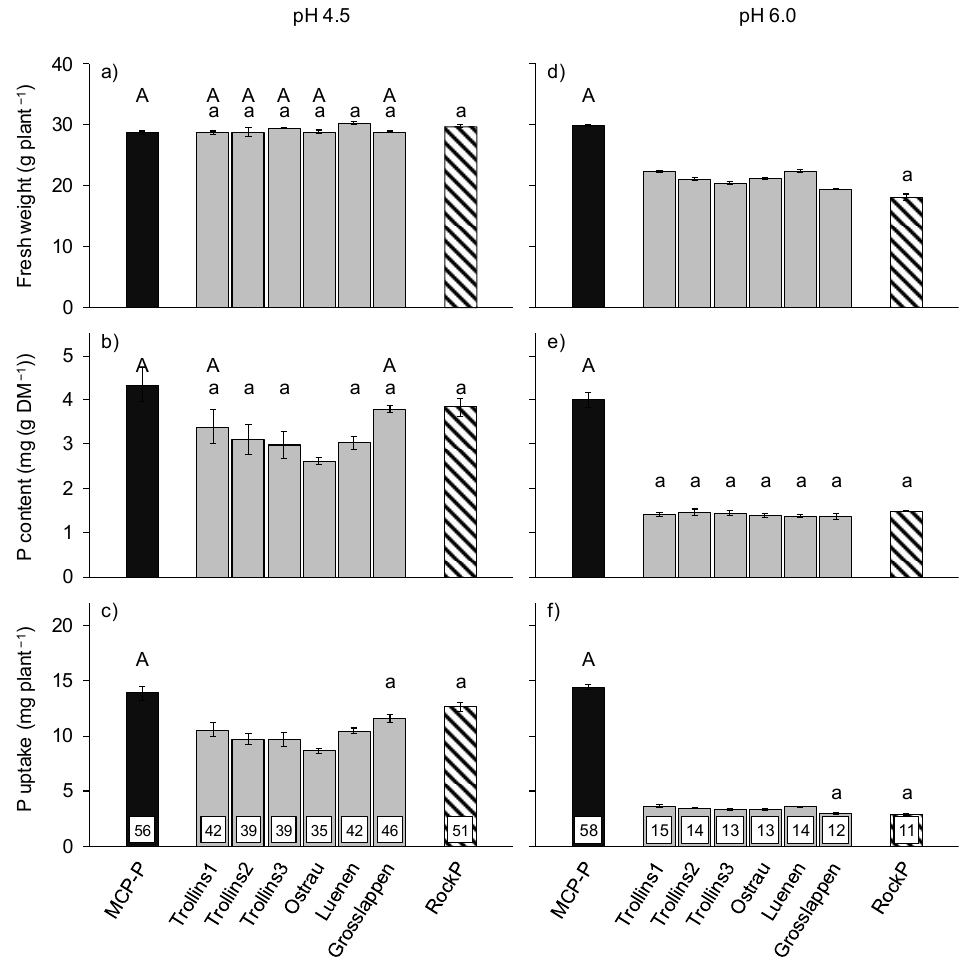
Figure 1. Fresh weight ( a , d ), phosphorus (P) content ( b , e ) and P uptake ( c , f ) of marigold plants fertilized with different sewage sludge ashes (Trollins1, Trollins2, Trollins3, Ostrau, Luenen, Grosslappen), monocalcium phosphate (MCP) or rock phosphate (RockP) after cultivation for four weeks under contrasting pH conditions (4.5, 6.0). Values in the columns of subfigures c and f indicate the P use efficiency in % of applied P. Sewage sludge ashes with capital “A” did not differ significantly from MCP control, nor did those with lowercase “a” from RockP control (Dunnett test, p < 0.05). Error bars represent the standard error of mean (n = 4).